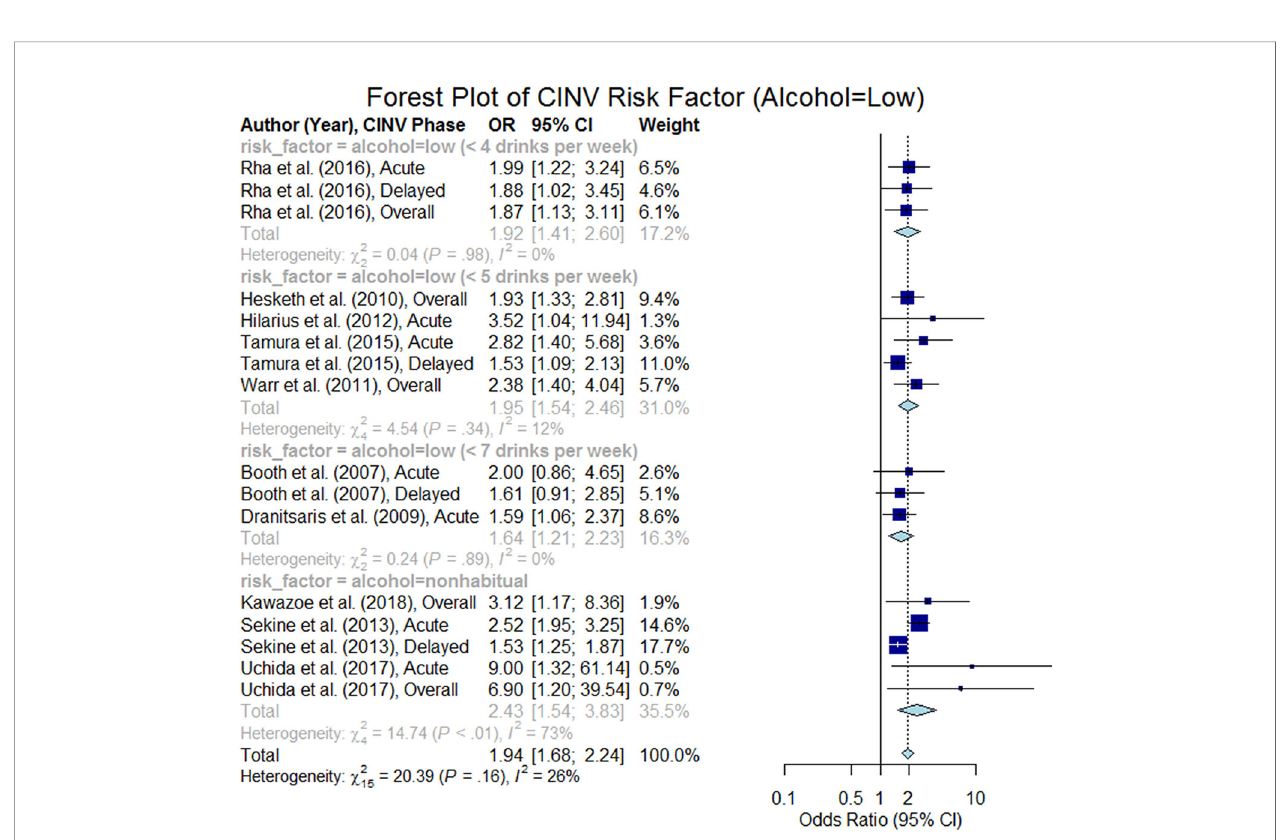
FIGURE 5 | Forest plot of Chemotherapy-Induced Nausea and Vomiting (CINV) risk factor (alcohol =